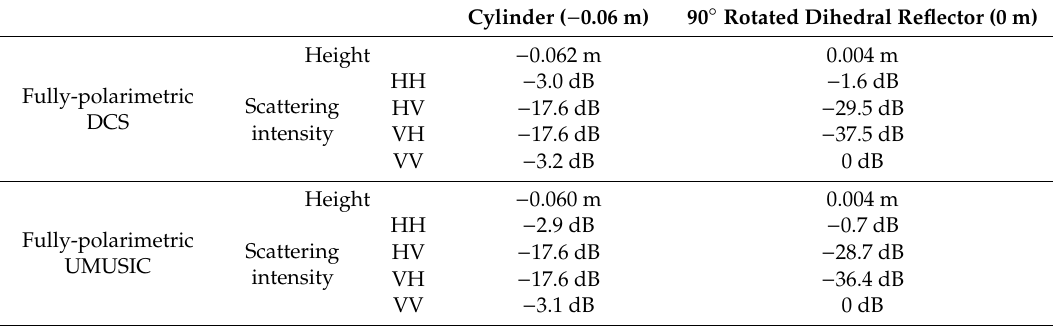
Figure 5. Estimated results of two point scatterers with a spacing of 0.06 m by ( a ) fully-polarimetric DCS and ( b ) fully-polarimetric UMUSIC. Table 2. Estimated results of two point scatterers with a spacing of 0.06 m.